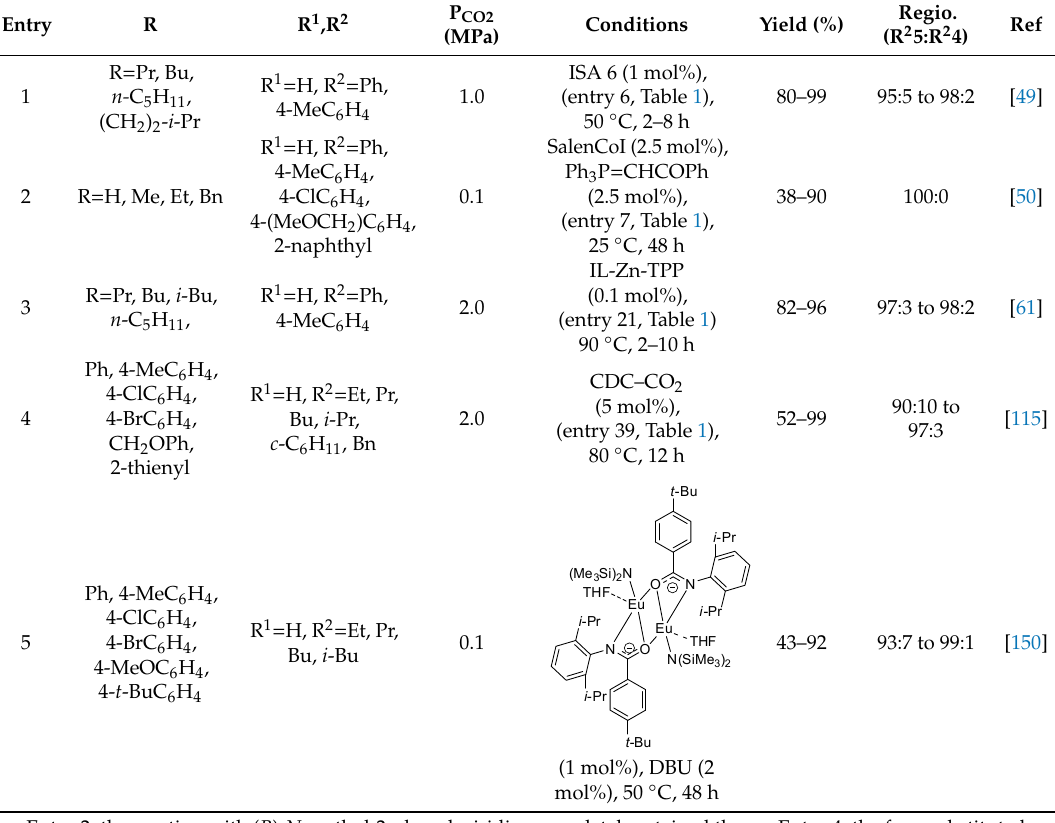
Table 3. Catalysts for the reaction of aziridines and carbon dioxide (R, R 1 , and R 2 see Scheme 13).